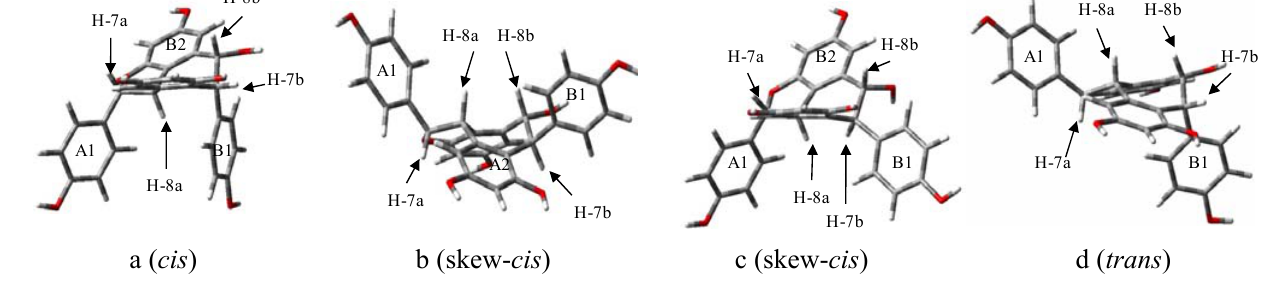
3. Energy-optimized stereo structures of 1 ( a ), (+)-ampelopsin A ( b ), ( − )-hemsleyanol A ( c ) and (+)-balanocarpol ( d ).